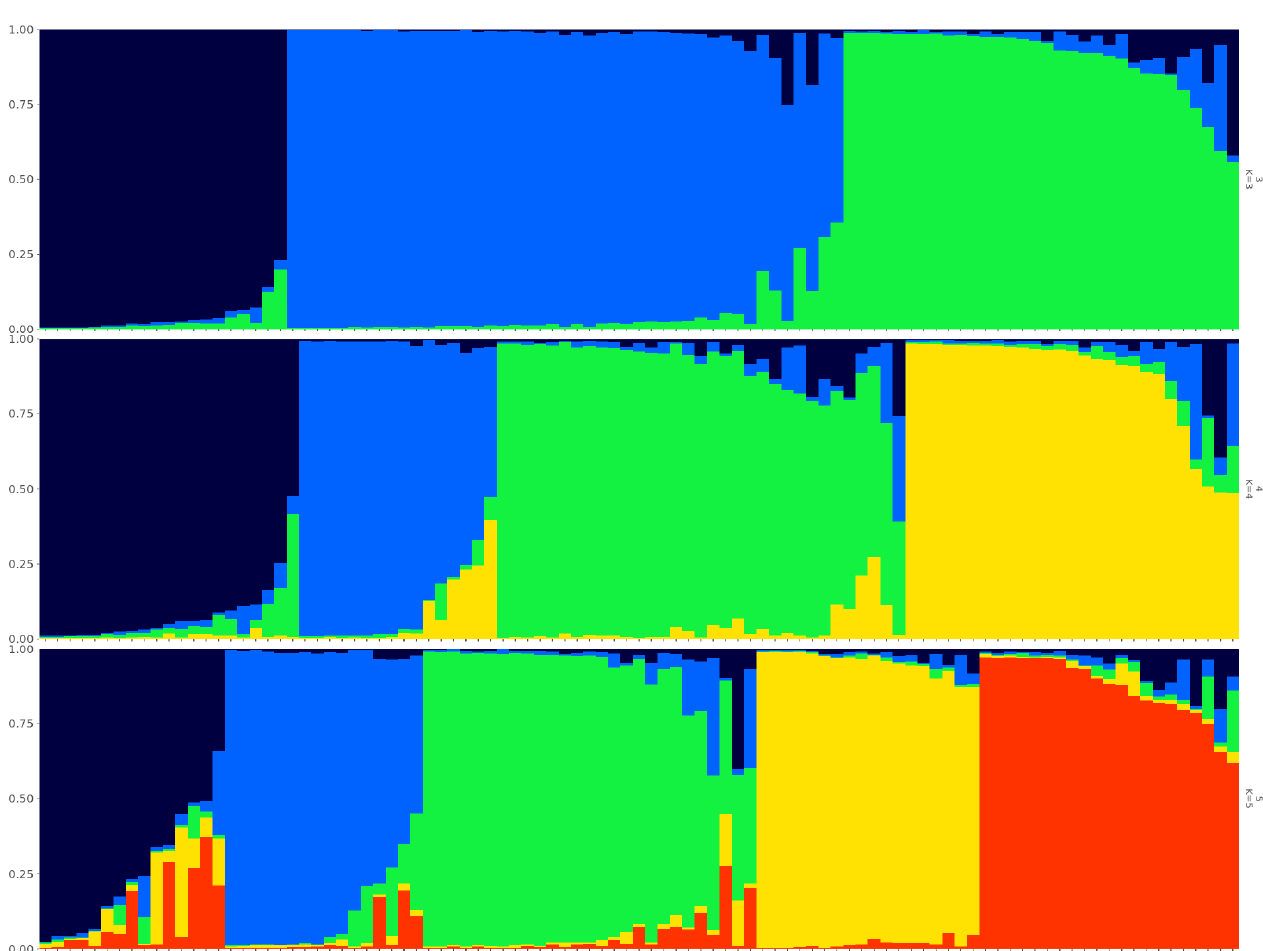
Figure 4. The population structure diagram for K = 3, 4, and 5 for the 97 chrysanthemum cultivars tested. Each bar represents one test object, divided by colors according to the group of belonging. Cultivars are ordered by groups. Information on each genotype can be found in Supplementary Table S5A–C.